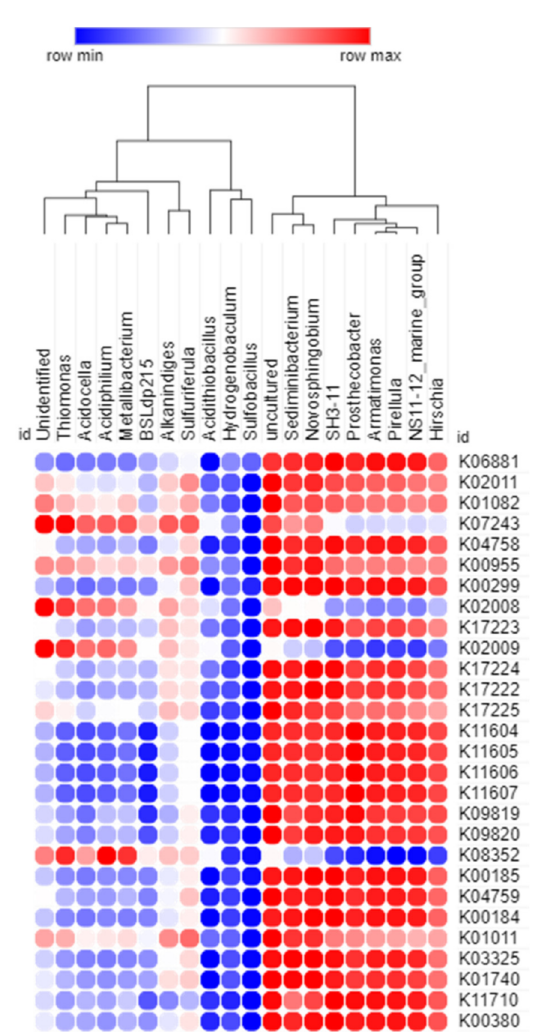
Figure 8. Spearman correlation analysis between bacterial genera of the three watersheds and their metabolic functional predictions. The positive and negative correlations are shown in red and blue colors,